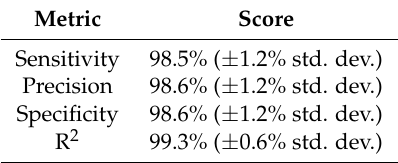
Table 1. Main SCG annotation performance: individual scores.